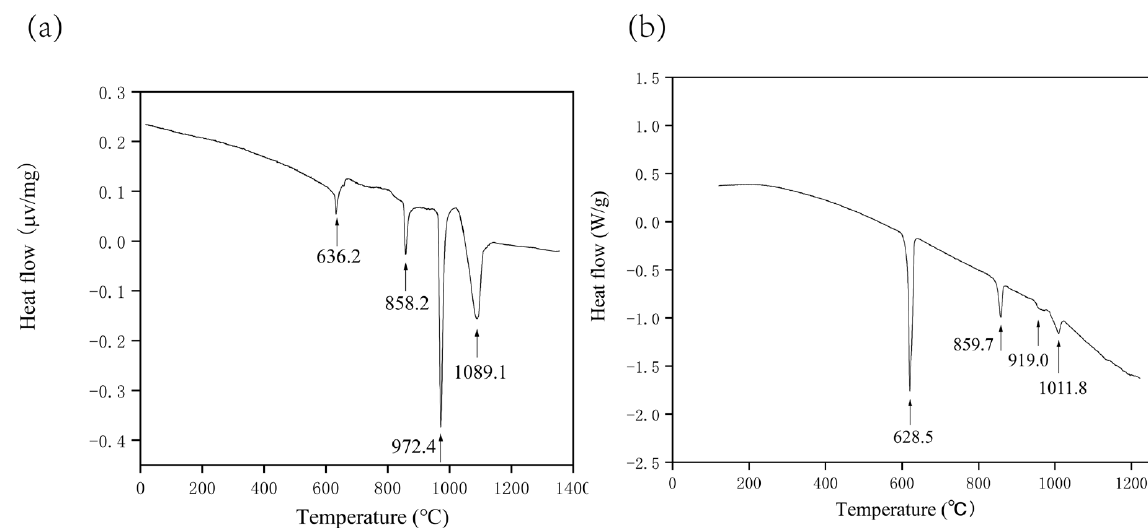
Figure 15. DSC curves of Samples ( a ) 12 and ( b ) 19.